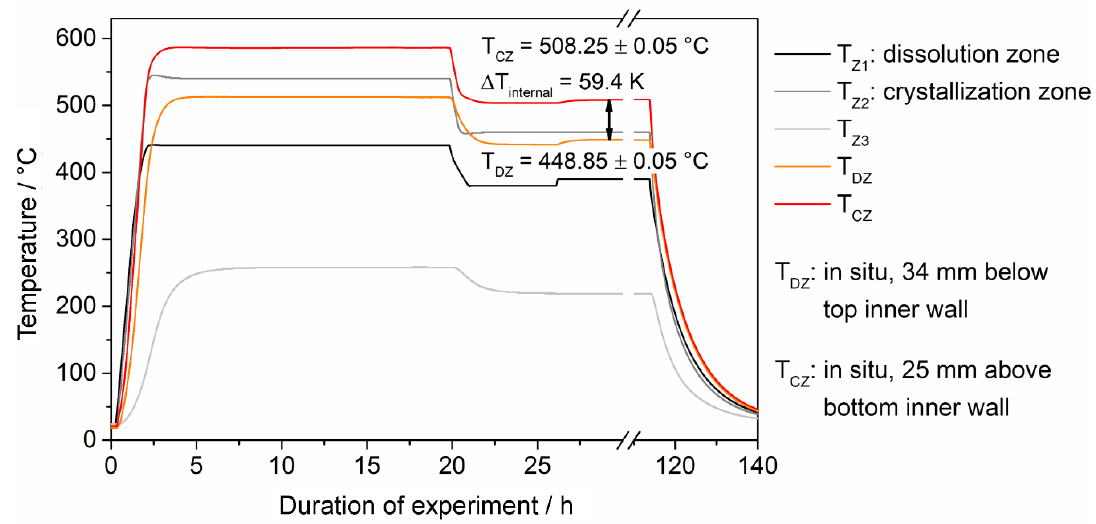
Figure 7. Temperature data of experiment A1 (air) over time. For an illustration of the locations of measurement see Figure 1. The value ∆ T internal refers to the temperature difference between the two internal temperature measurements. Reprinted from [21].